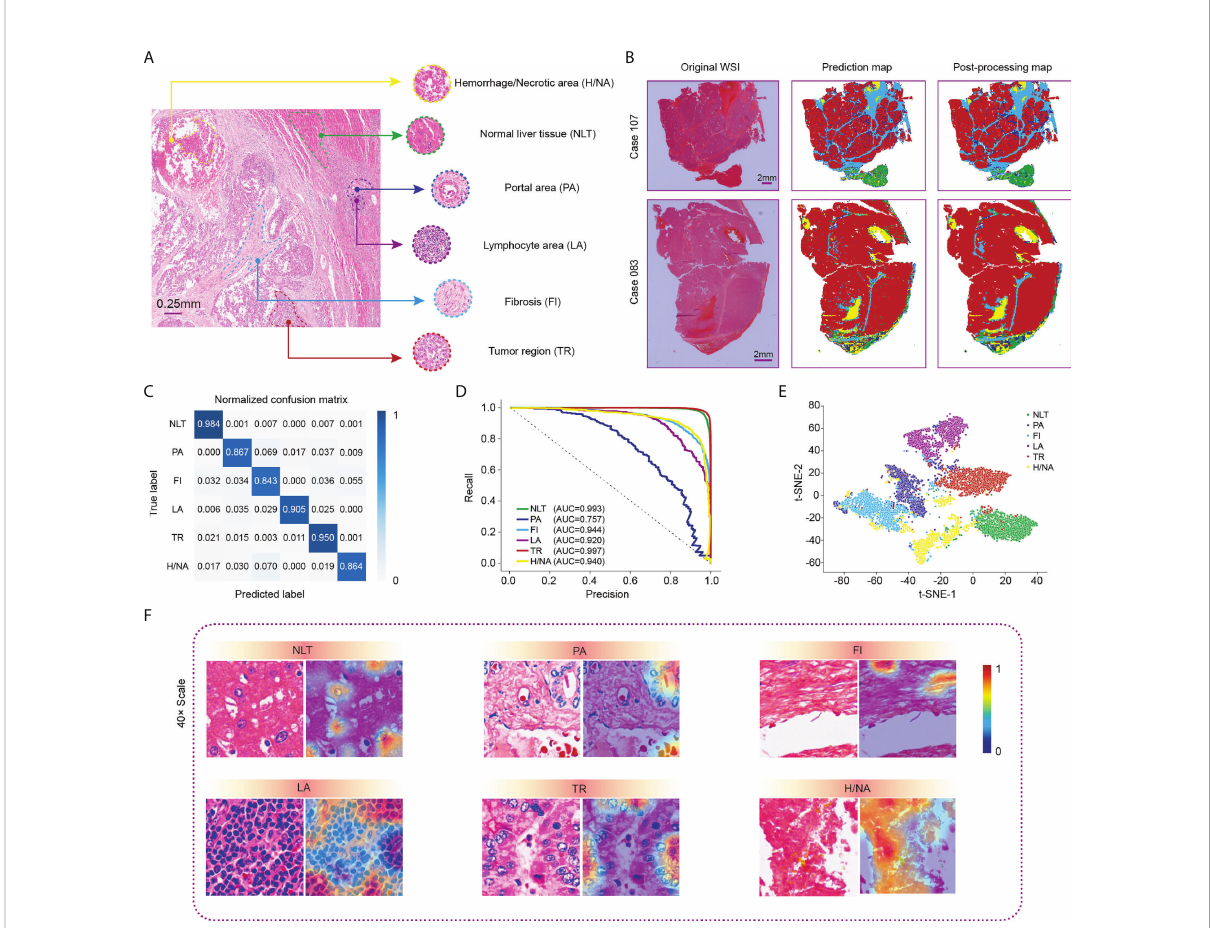
FIGURE 2 Visualization of WSI classi fi cation for HCC tissue in the Zhongshan cohort. (A) Six classic categories of HCC tissue, including normal liver tissue (NLT), portal area (PA), fi brosis (FI), lymphocyte area (LA), tumor region (TR) and hemorrhage/necrotic area (H/NA). (B) Two representative outputs of the classi fi cation network. Red represents TR, green represents NLT, light blue represents FI, dark blue represents PA, purple represents LCA, and yellow represents H/NA. (C) Precision-recall curve of category-based sampling. (D) Normalized confusion matrix for the classi fi cation network. (E) t-SNE analysis for visualization of six tissue categories. (F) CAM results for visualization of HCC tissues. HCC, hepatocellular carcinoma; CAM, class activation mapping; t-SNE, t-distributed stochastic neighbor